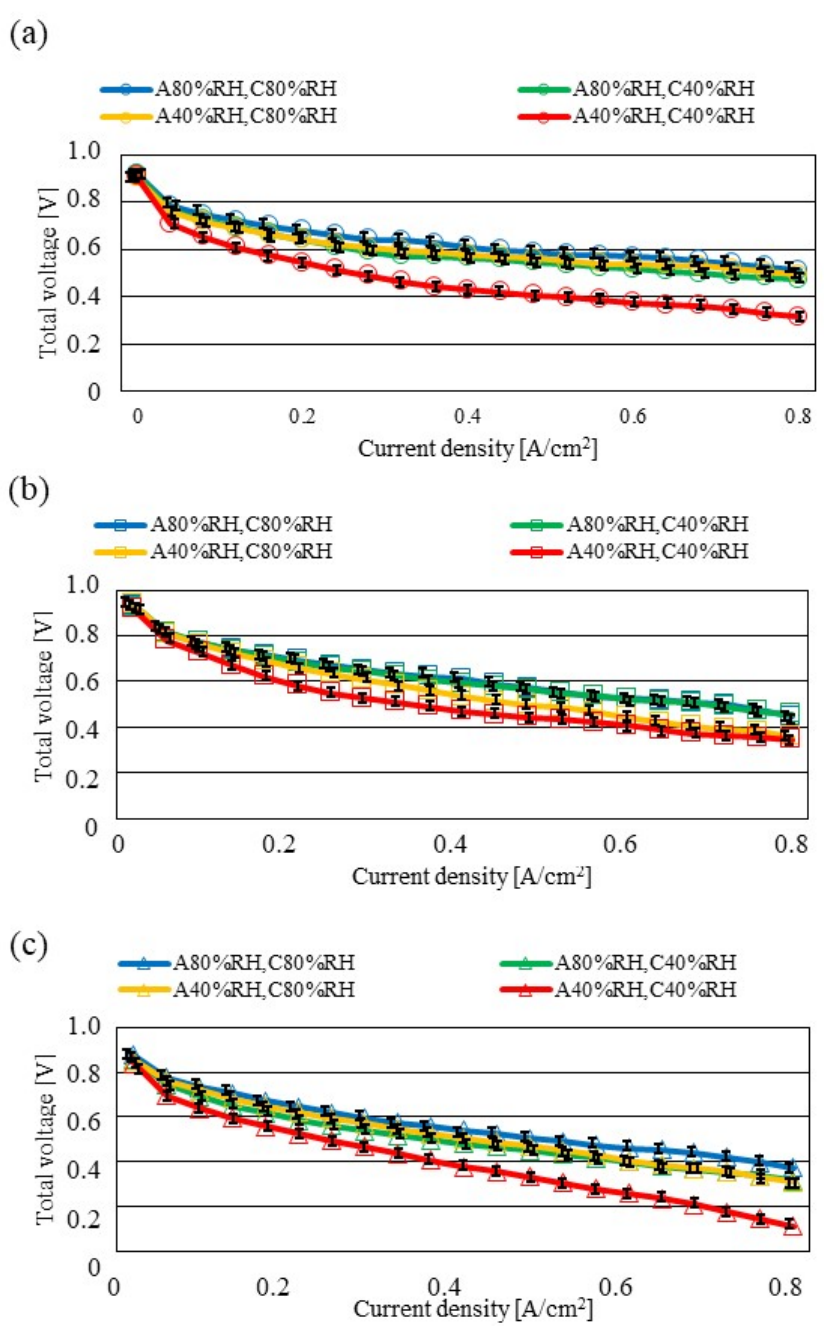
Figure 6. Comparison of polarization curves among different RHs for a separator thickness of 1.0 mm: ( a ) T init = 353 K; ( b ) T init = 363 K; ( c ) T init = 373 K. A80%RH&C80%RH, A80%RH&C40%RH, A40%RH&C80%RH and A40%RH&C40%RH were